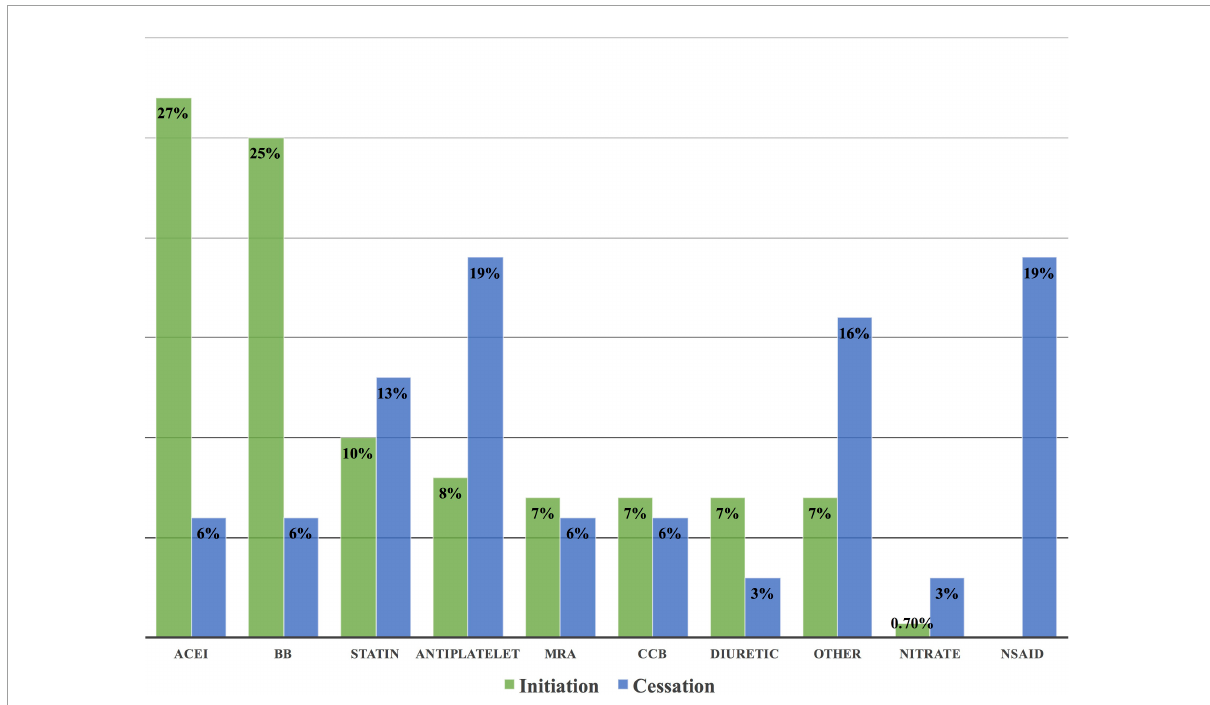
FIGURE9 Frequency of drug cessation and initiation at the cardio-oncology clinic. Non-steroidal anti-inflammatory drugs and antiplatelets were the most common drugs to be stopped at the cardio-oncology clinic due to the lack of indication for their use or due to exacerbation of the underlying cardiovascular disease or risk factor. ACEI and beta-blockers were the most common drugs to be initiated at the clinic because of their integral role in the management of CVRF/CVD, in addition to cancer therapy-related cardiac dysfunction. ACEI, angiotensin-converting enzyme inhibitors; BB, beta-blockers; CCB, calcium channel blockers; NSAID, non-steroidal anti-inflammatory drug; MRA, mineralocorticoid receptor